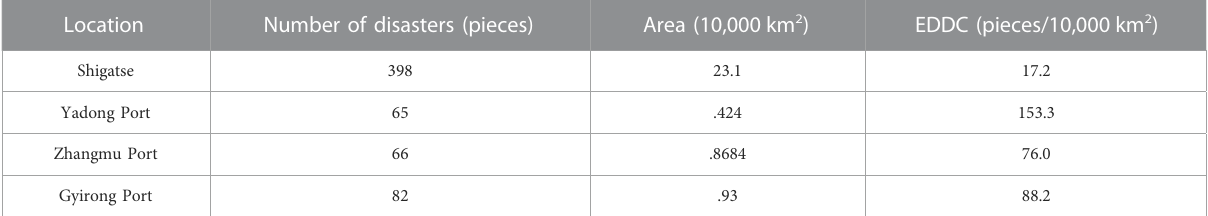
TABLE 4 Speci fi c division principle of stratigraphic lithology. Engineering geological rock group Typical lithology Strength grading Hard magmatic rock group Hard sedimentary rock group